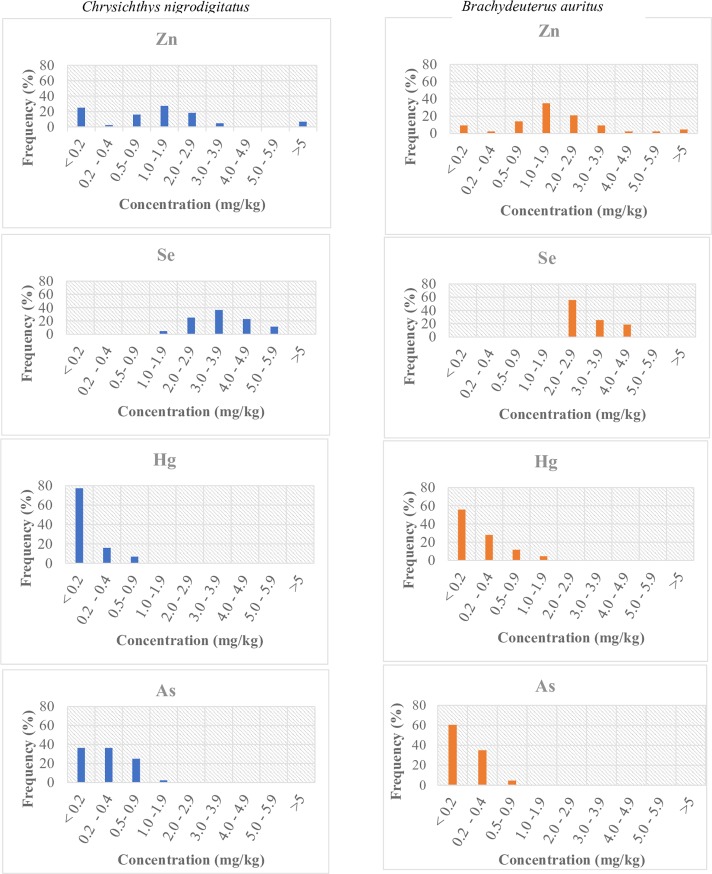
Frequency distribution of metal concentrations in the muscle tissues of Chrysichthys nigrodigitatus and Brachydeuterus auritus from the waters of Ghana.Note: Pb, Cd and Cu were excluded from Fig 1 because Pb and Cd were below detection in all samples while 96% of the C. nigrodigitatus and 100% of the B. auritus samples had Cu levels below detections.